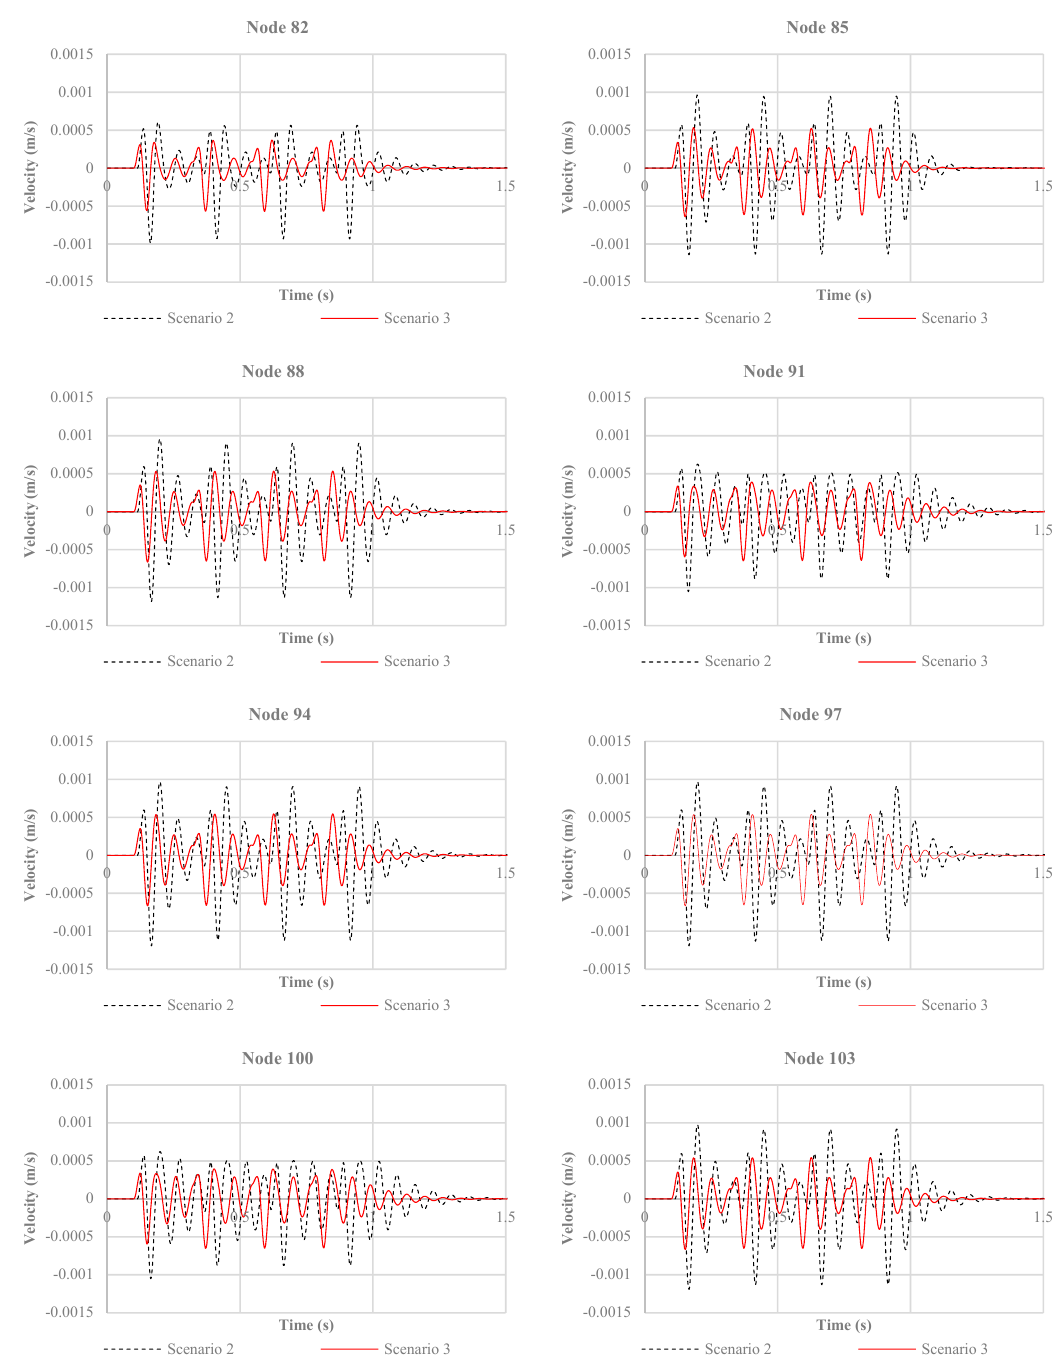
Figure 11. Comparison between the two excavation techniques in terms of vertical displacement time histories of the control points.